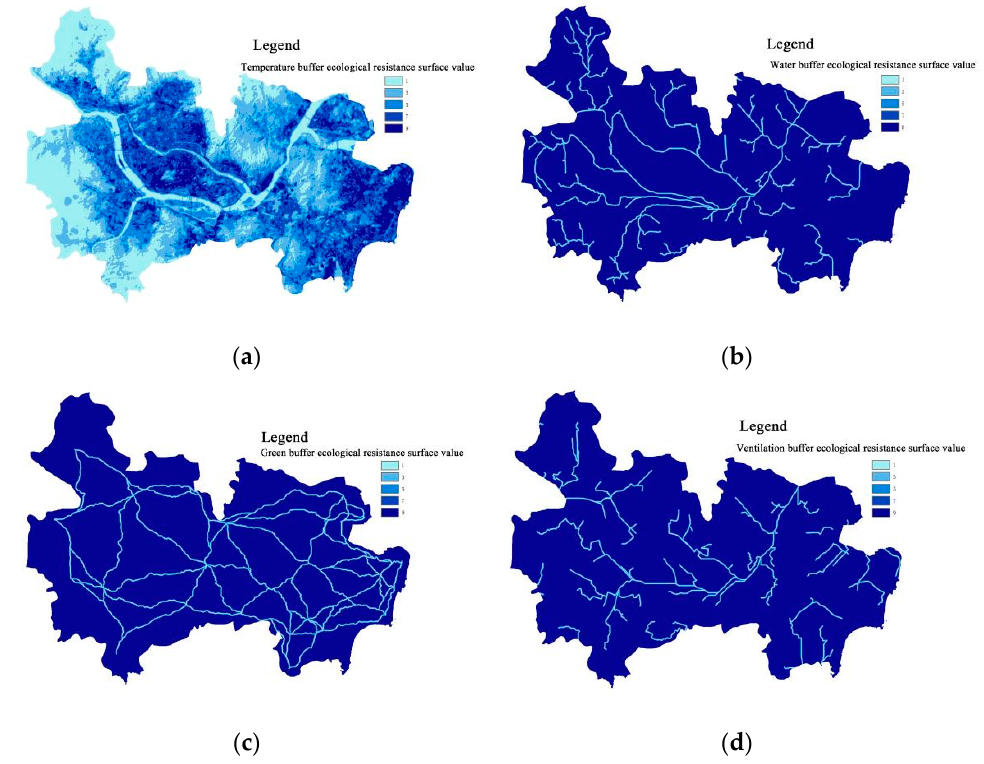
Figure 5. Ecological resistance surface: ( a ) temperature buffer ecological resistance surface factor; ( b ) water buffer ecological resistance surface factor; ( c ) green buffer ecological resistance surface factor; ( d ) ventilation buffer ecological resistance surface factor.